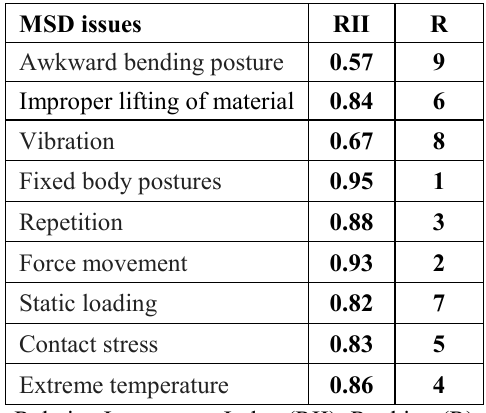
Table 3. Factors Contributing to the Development of MSDs